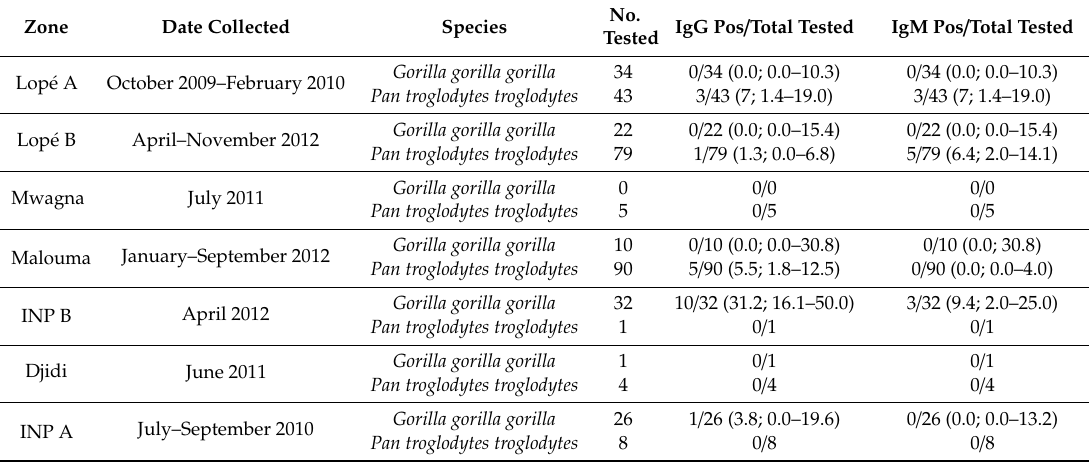
Table 1. Prevalence of immunoglobulin G (IgG) and immunoglobulin M (IgM) EBOV antibodies in fecal samples of apes by sampling zone in Gabon between 2009 and 2012.